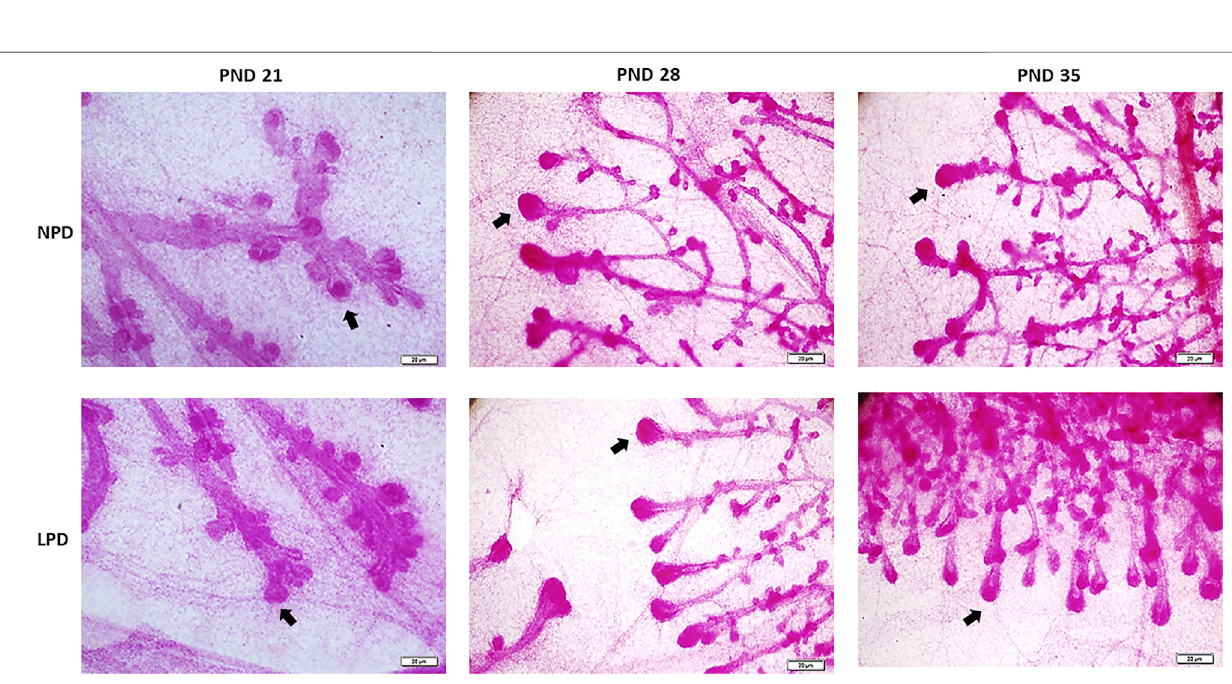
Frontiers in Cell and Developmental Biology |